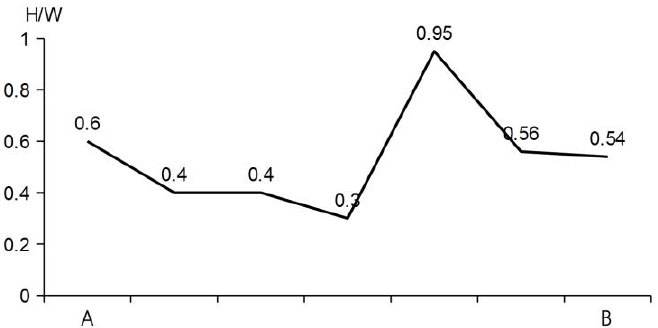
Figure 9. The height-to-street width ratios of the street-facing buildings in the renewal site (The x-axis represents, from left to right, the height-to-width ratio of the buildings passing from point A to B).